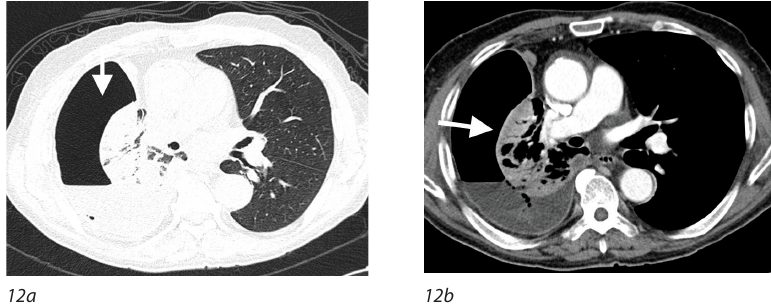
Fig. 12. Right pneumothorax (arrow in 12a) with atelectasis of underlying lung (arrow in 12b) and pleural